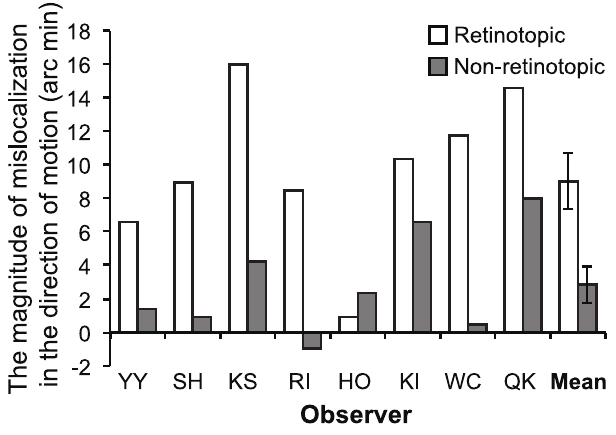
Figure 4. The results of the Experiment 2. Individual and mean data are shown. Error bars denote standard errors of the mean.